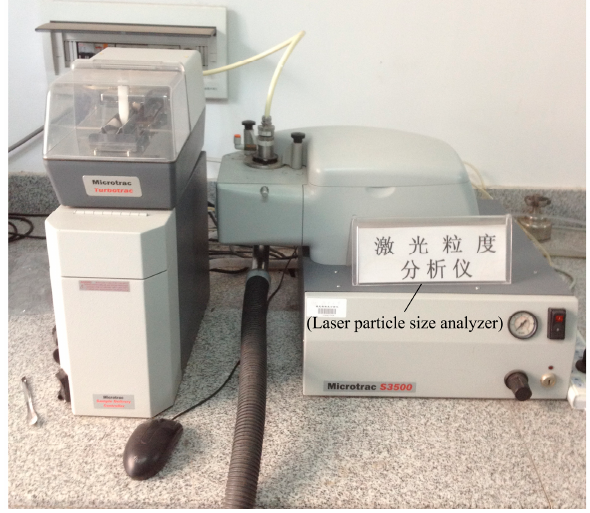
Figure 2. Laser particle size analysis.